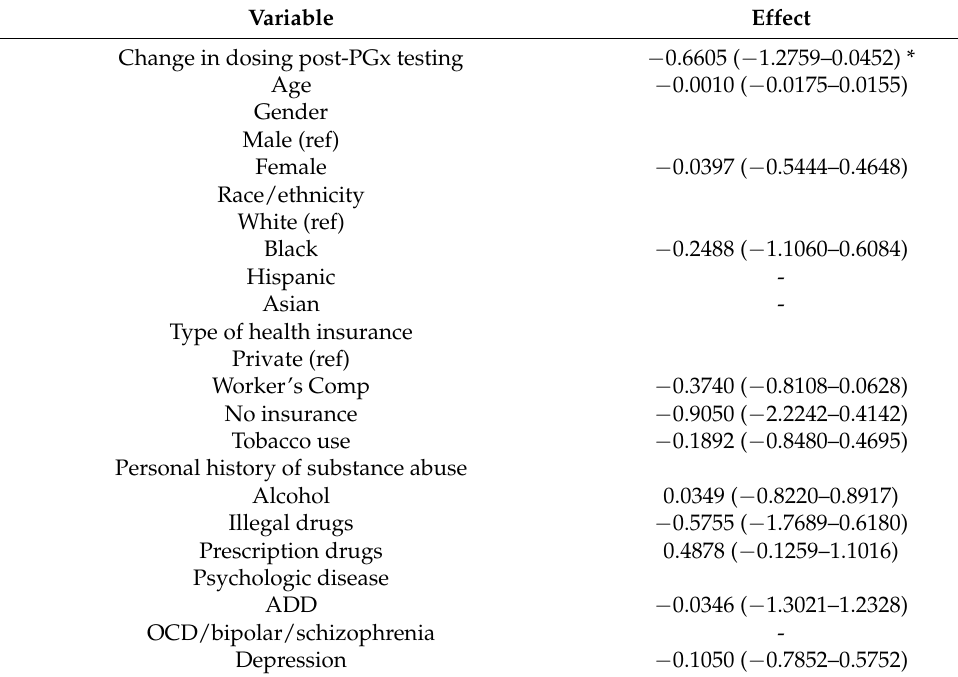
Table 8. Effect of change in dose post-pharmacogenomic (PGx) testing on patient pain scale among those without change in medication post-PGx testing (N =